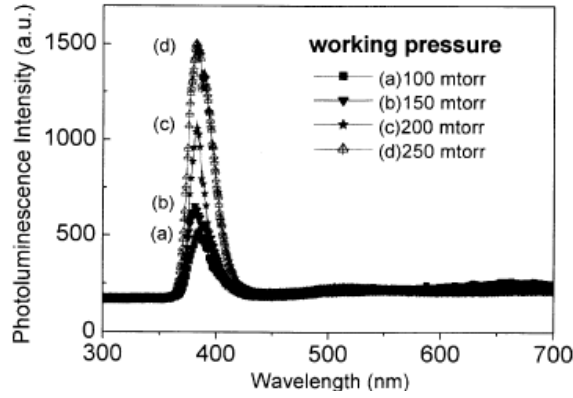
Figure 3. Photoluminescence spectra of ZnO films deposited under various working pressures. Reprinted from [19] with